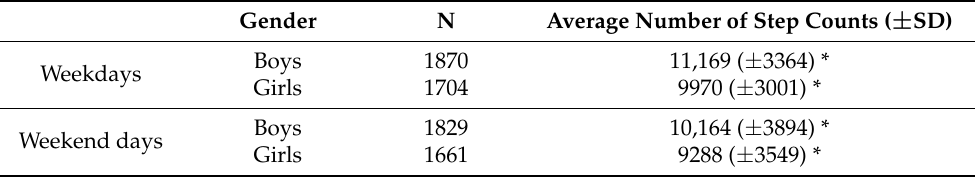
Table 2. Amount of step counts in preschool boys and girls, across the participating